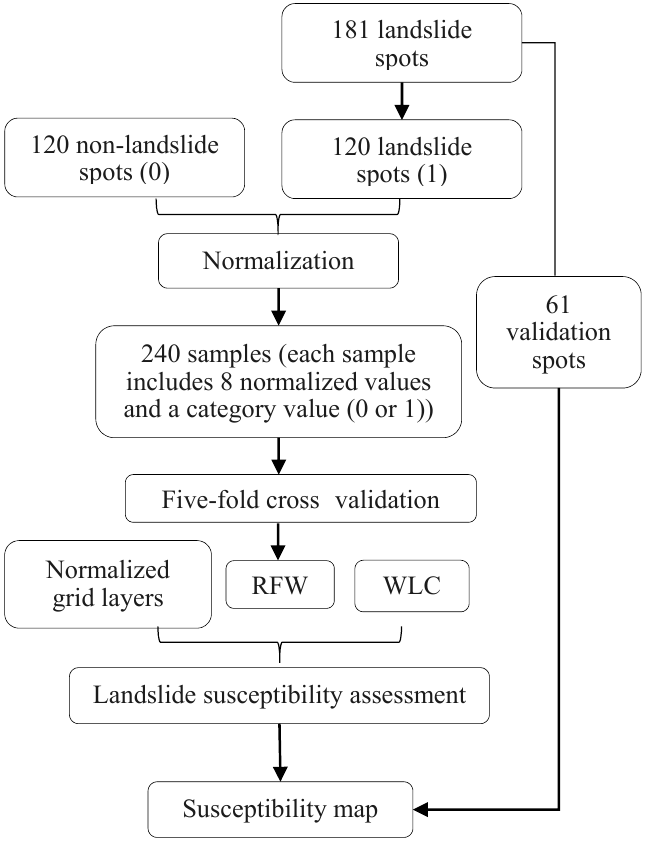
Figure 6. The flow chart of the landslide susceptibility assessment in the Beijiang River Basin.